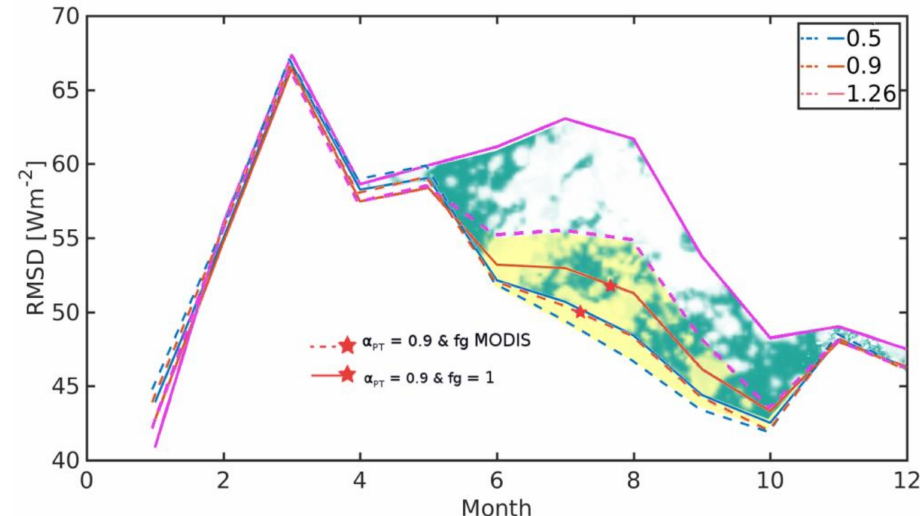
Figure 8. Latent heat flux RMSD (W m − 2 ) modifying the Priestley–Taylor coefficient from 0.5 to 1.5 with constant f g and variable f g , for Las Majadas. The green/white area represent the width between the upper limit ( α PT = 1.26) and the lower limit ( α PT = 0.5) using f g = 1, and the yellow area shows the reduce amplitude integrating a variable f g calculated from MODIS (dashed